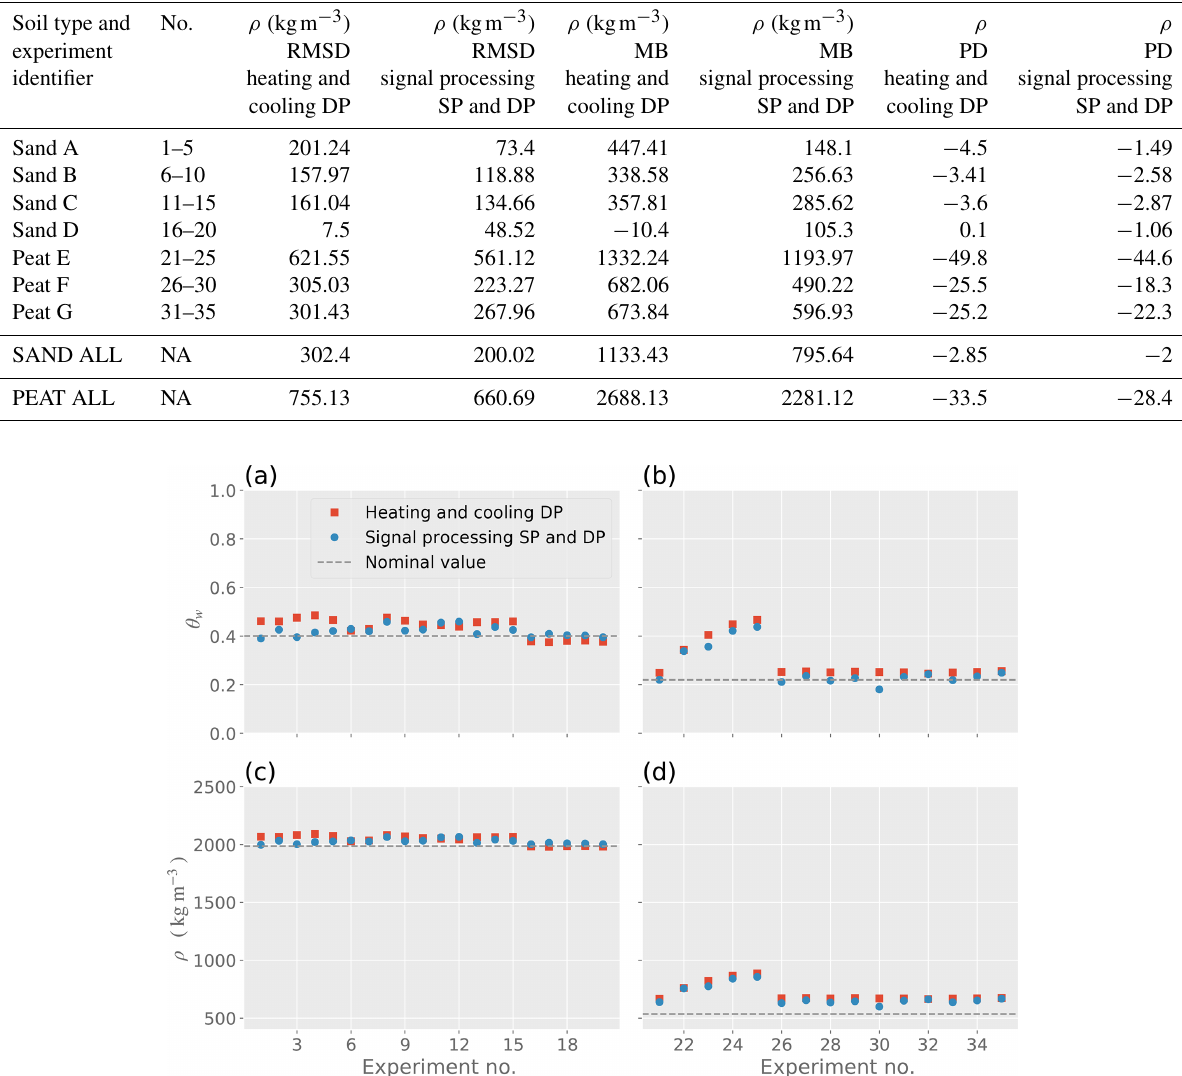
Table 7. RMSD, MB, and PD comparisons for ρ .